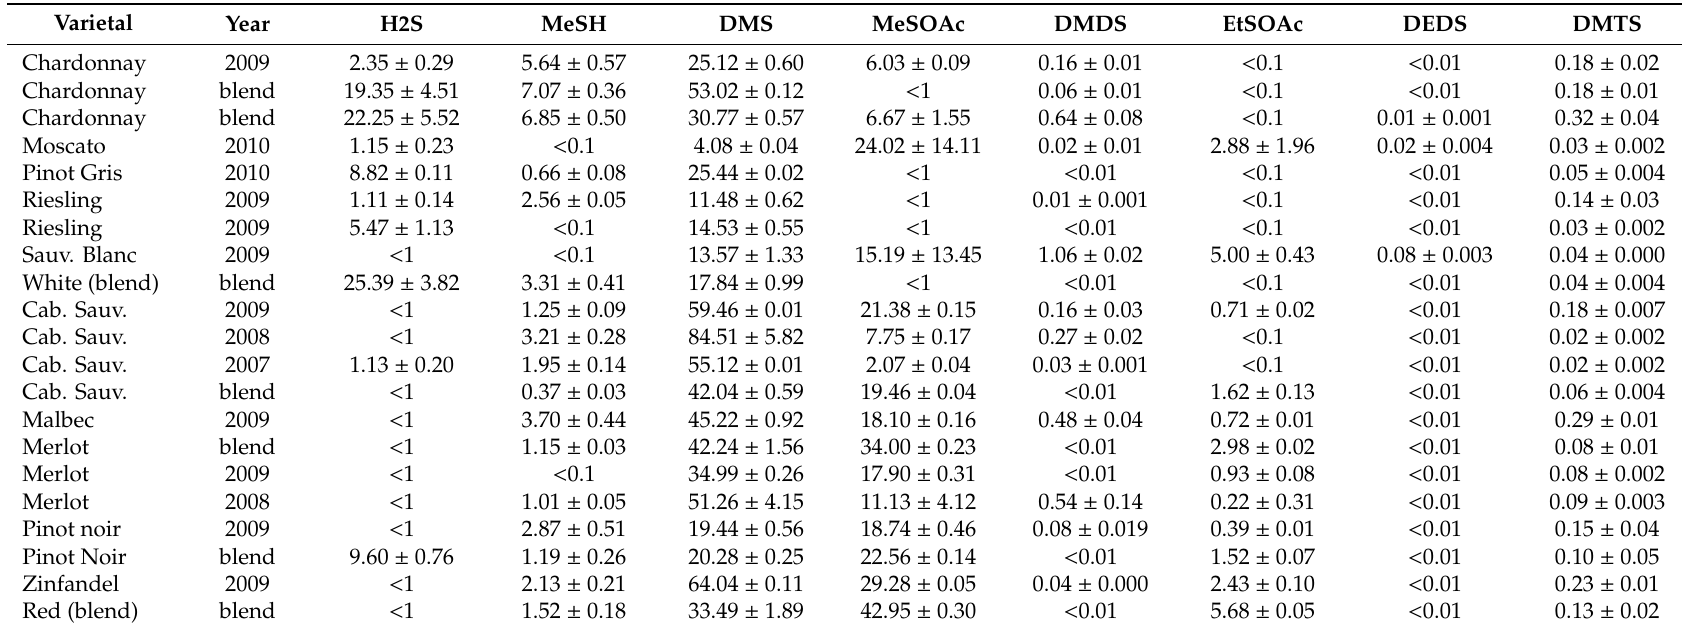
Table 1. Quantification of sulfur volatiles in 21 di ff erent wines ( µ g /